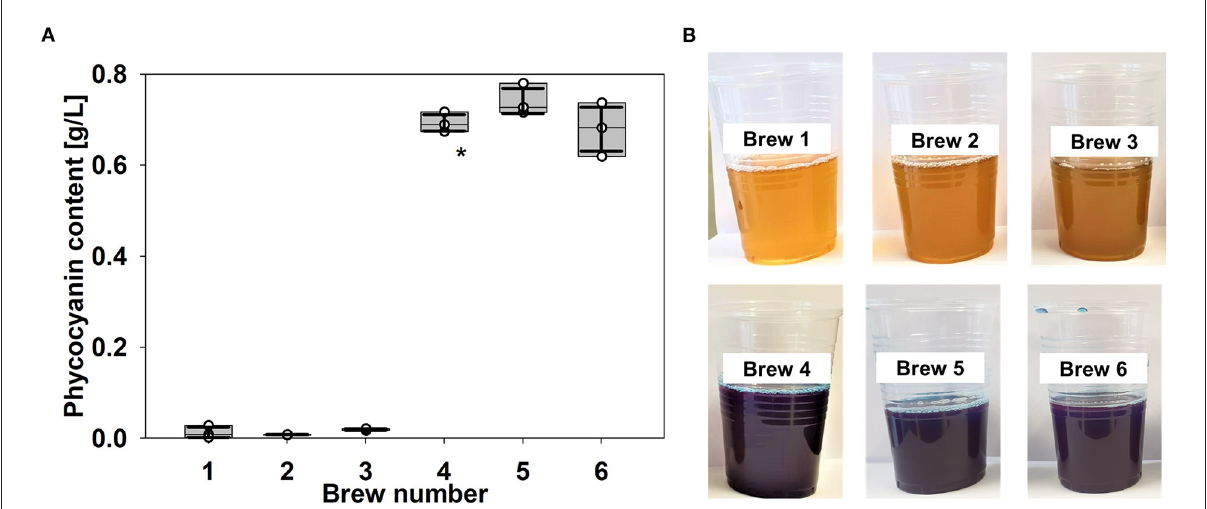
FIGURE3 Phycocyanin content of the beers. Brews 1–4: mild pale ale style. Brews 5 and 6: India pale ale style. Boxplot and data shown (circles, n = 3) (A) . Box plots compile the median and quartiles. In addition, standard deviation was added as error bar (thick line). Asterisk indicates